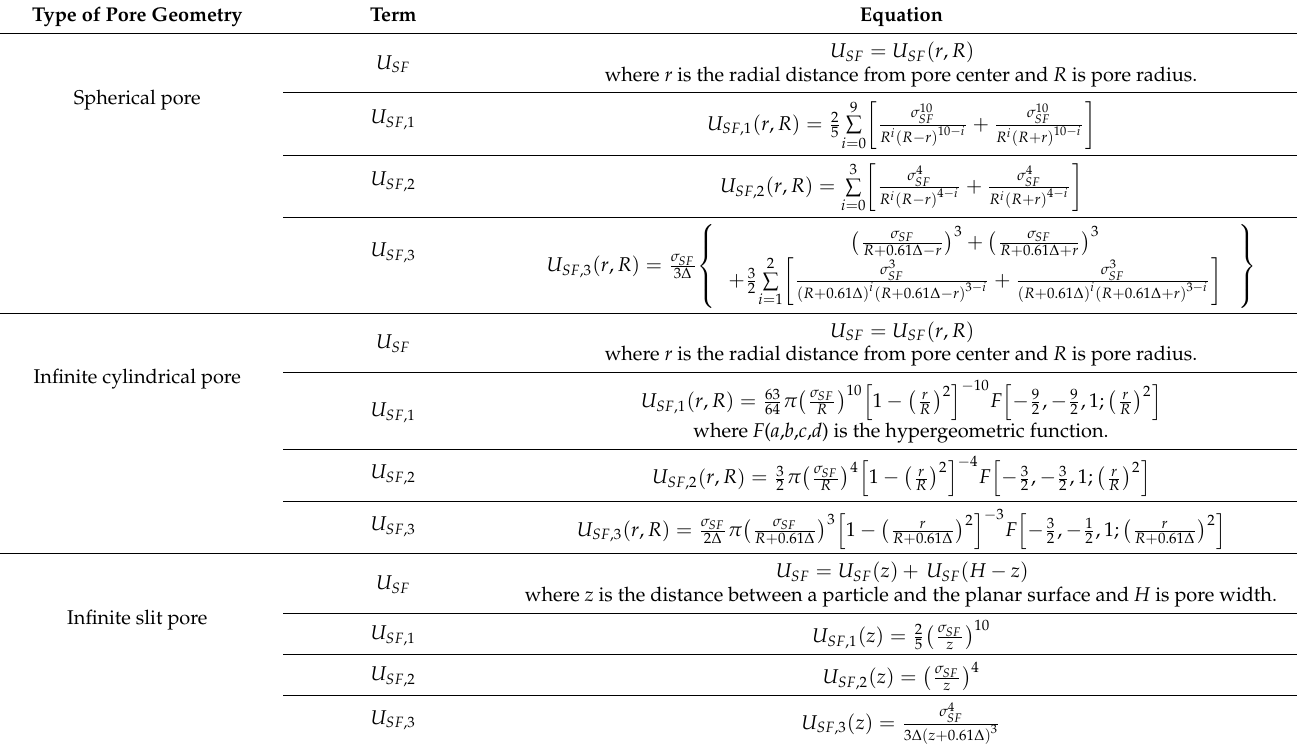
Table 3. Equations of U SF , U SF ,1 , U SF ,2 , and U SF ,3 used in Equation (3) based on different pore geome-